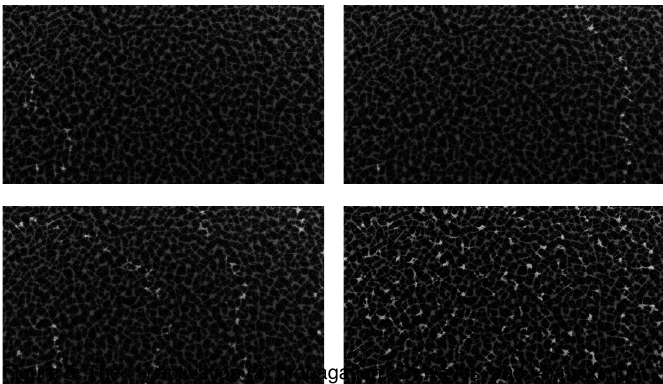
Figure 5. The (1) activation (2) propagation, (3) waves, and (4) maximum activity in a Feed sketch that uses a Physarum polycephalum simulation as a substrate, to focus on the activation mechanism. This builds on the model from Dismantling (2019), adding the layer of activation and shown through the brightness of points, in an unchanging